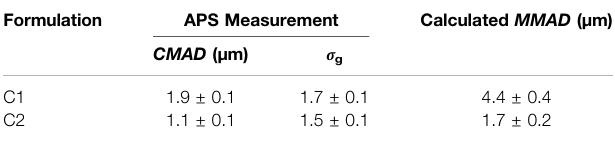
TABLE 7 | Measured particle size distribution of the dispersed C1 and C2 powders at the outlet of the RBG-NOID. Dispersion experiments were conducted at the optimized feed rate of 150 mm/h. Results shown are the average ± standard deviationofsixmeasurements forthe C1formulationand nine measurements for the C2